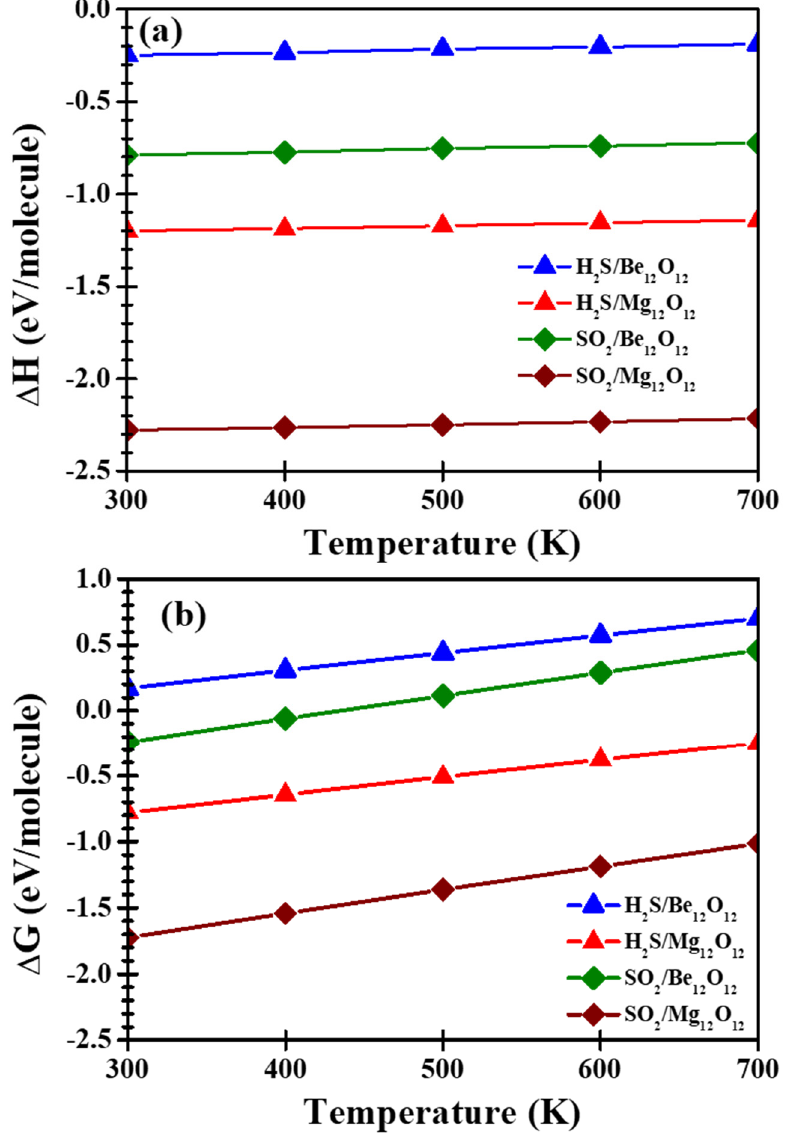
Figure 11. ( a ) ∆ H and ( b ) ∆ G for H 2 S/Be 12 O 12 , H 2 S/Mg 12 O 12 , SO 2 /Be 12 O 12 , and SO 2 /Mg 12 O 12 complexes.